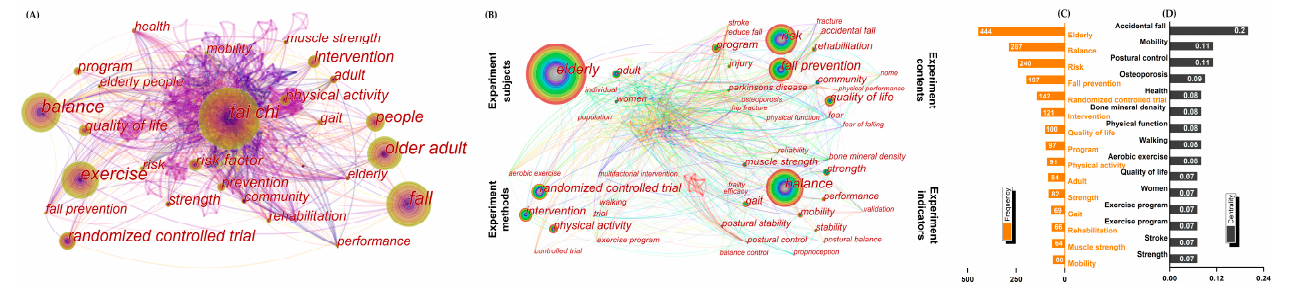
Figure 8. Visualized map of the keywords. ( A ) Original keywords map; ( B ) modified keywords map. Network: N = 271, E = 1291; ( C ) top ten keywords by publications; ( D ) top ten keywords by centrality.